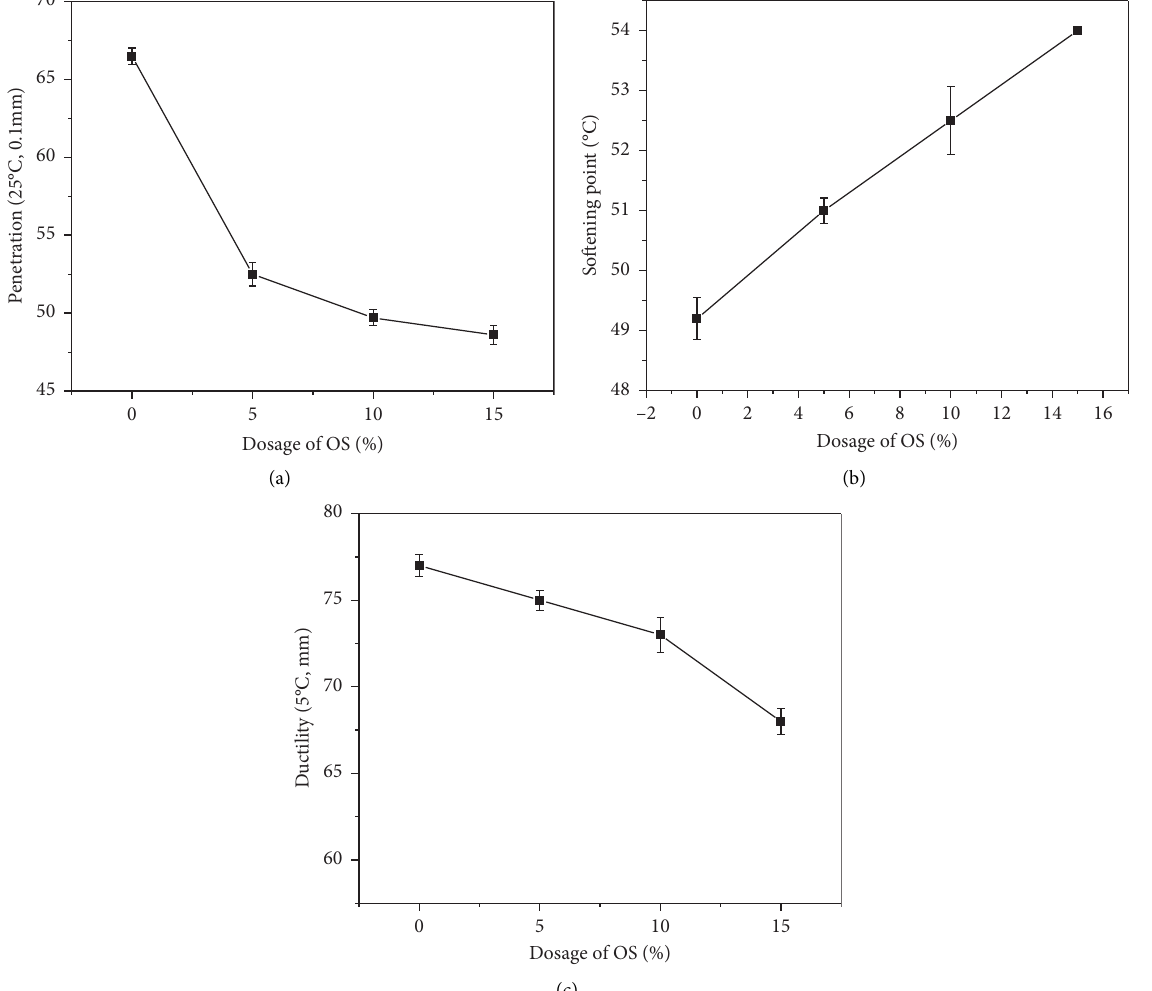
Figure 5: Conventional Performance of asphalt. (a) Penetration. (b) Softening point. (c)